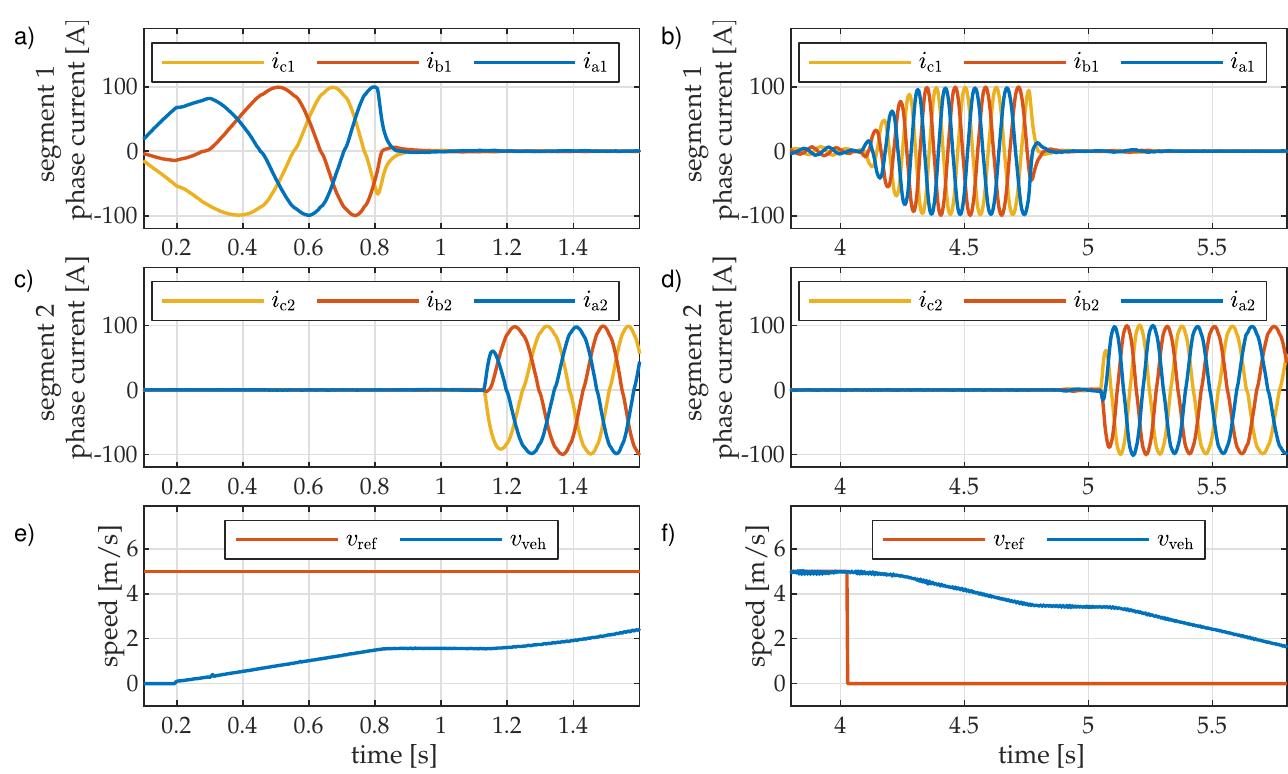
Figure 18. Experimental results for single-inverter configuration, left column—acceleration, right column—deceleration.